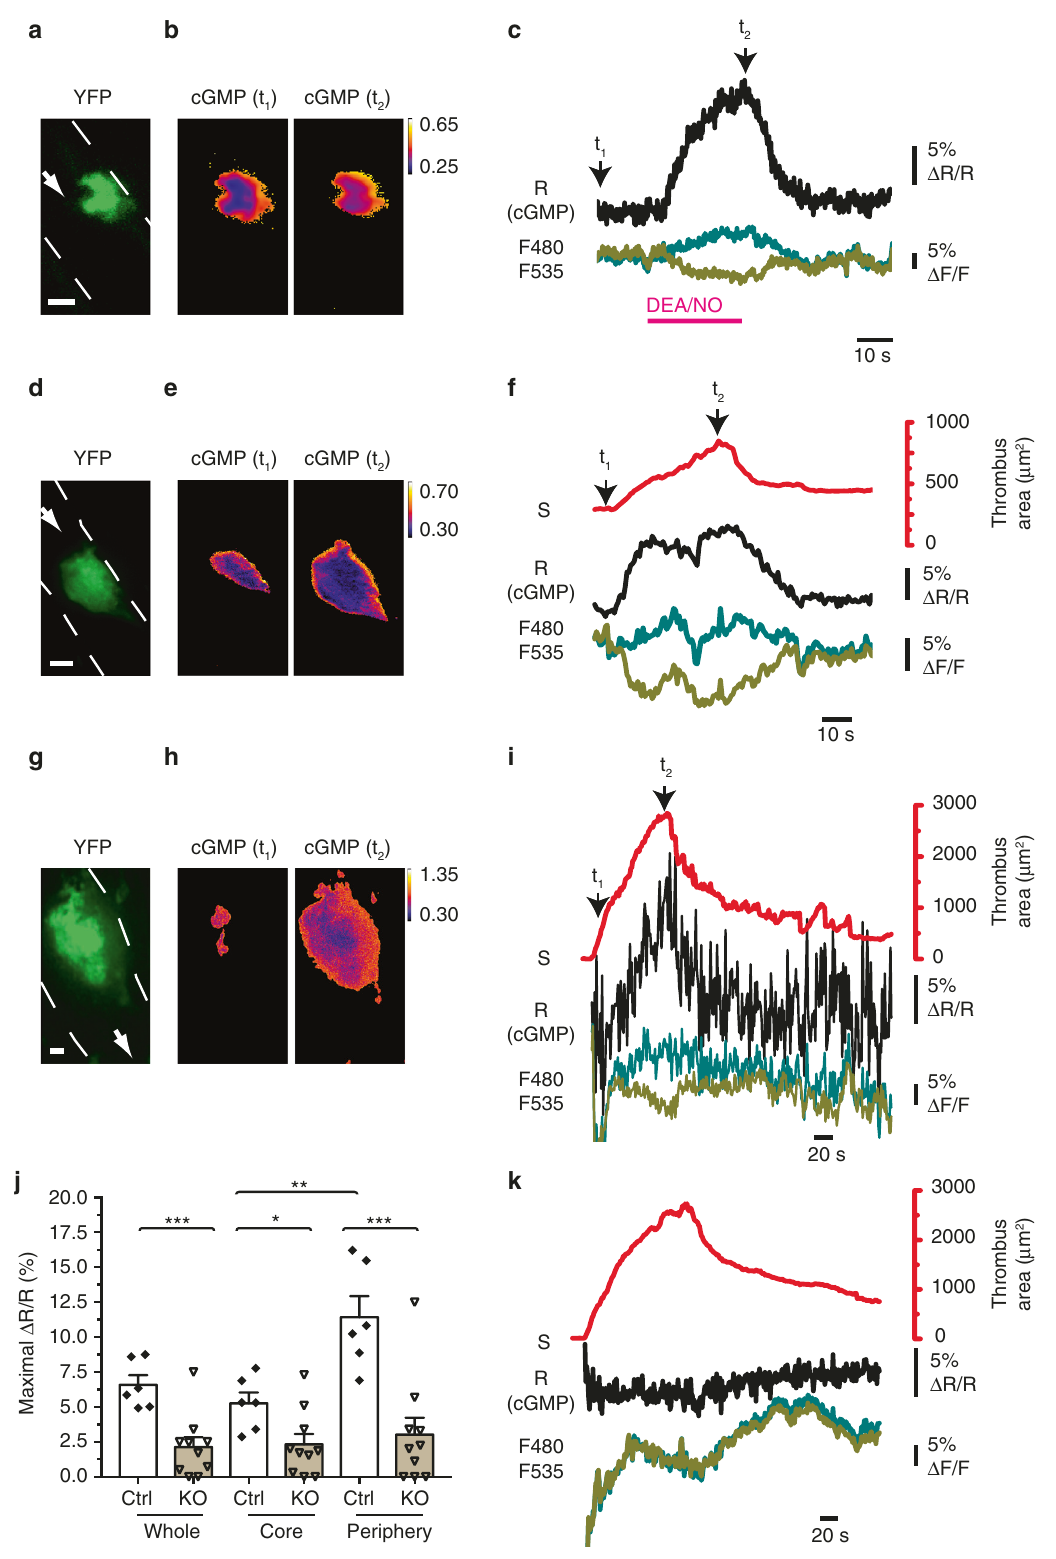
and phosphorylation of IRAG 32 . In line with this mechanism, fl ow-dependent regulation of Ca 2 + in the presence of NO was abolished in cGKI-de fi cient mouse platelets (Supplementary Fig. 8a, b). Moreover, the mechanosensitive NO-cGMP-Ca 2 + pathway also exists in human platelets (Supplementary Fig.